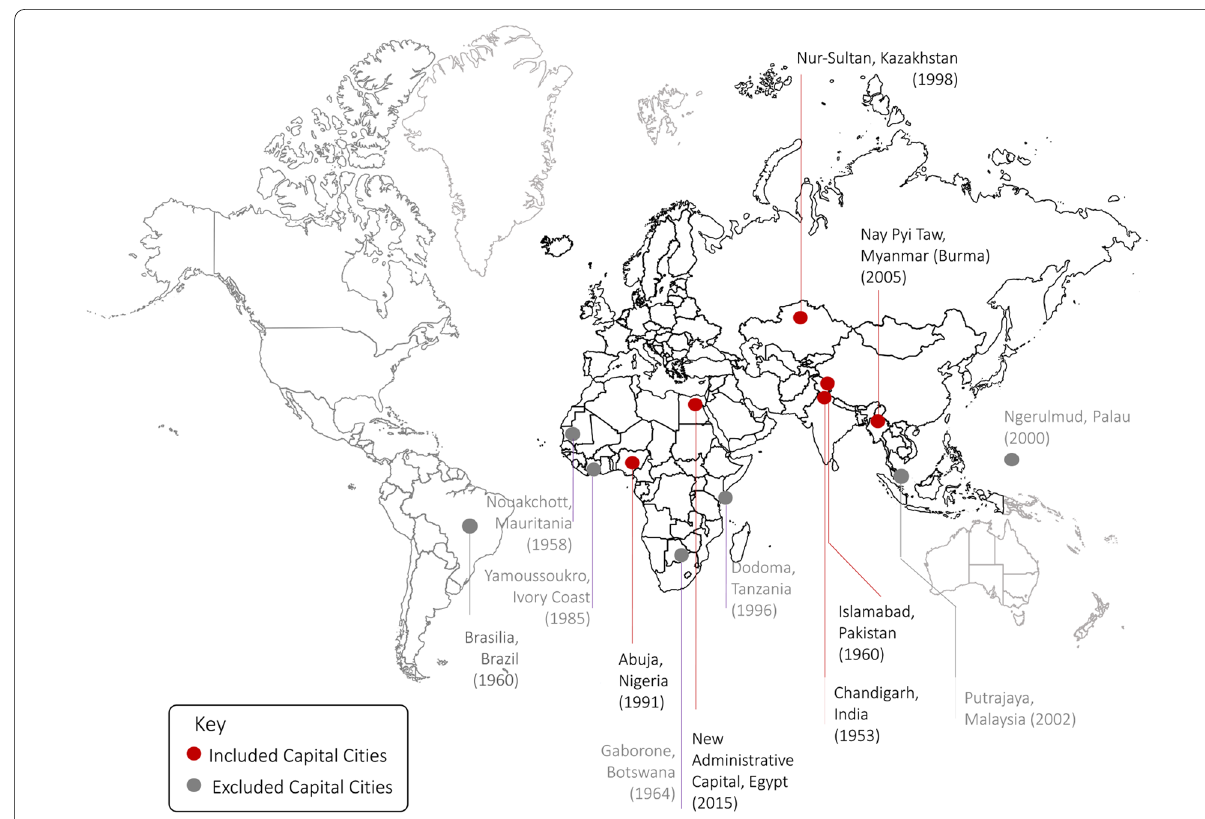
Fig. 1 The included and excluded capital